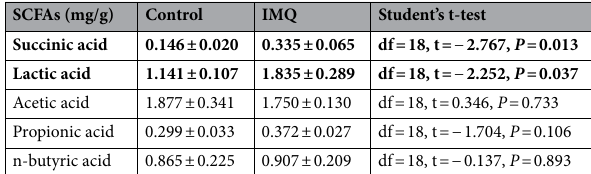
Table 1. Levels of short-chain fatty acids (SCFAs) in the fecal samples. The values are the mean ± S.E.M. (n = 10). Bold was statistically significant.